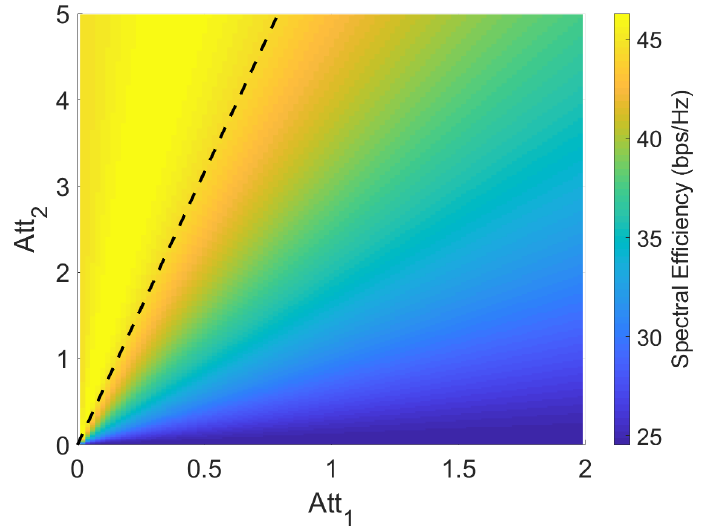
Figure 6. Spectral efficiency for a parametric sweep of Att 1 and Att 2 . The black line stands for the region where both MIMO subsystems are balanced in terms of power. The SINR is fixed to 30 dB and the values are averaged over the 101 frequency samples.